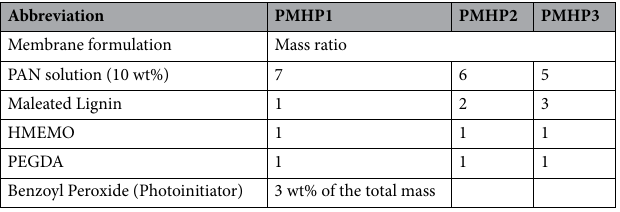
Table 1. The mass ratio of the precursor